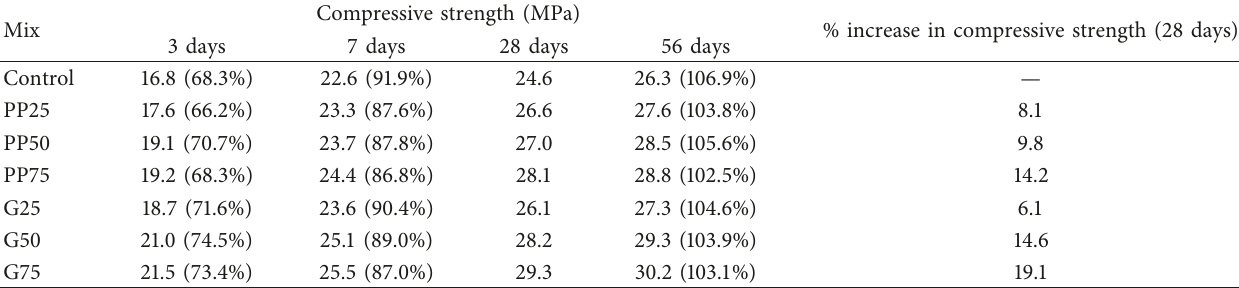
Table 4: Compressive strength of